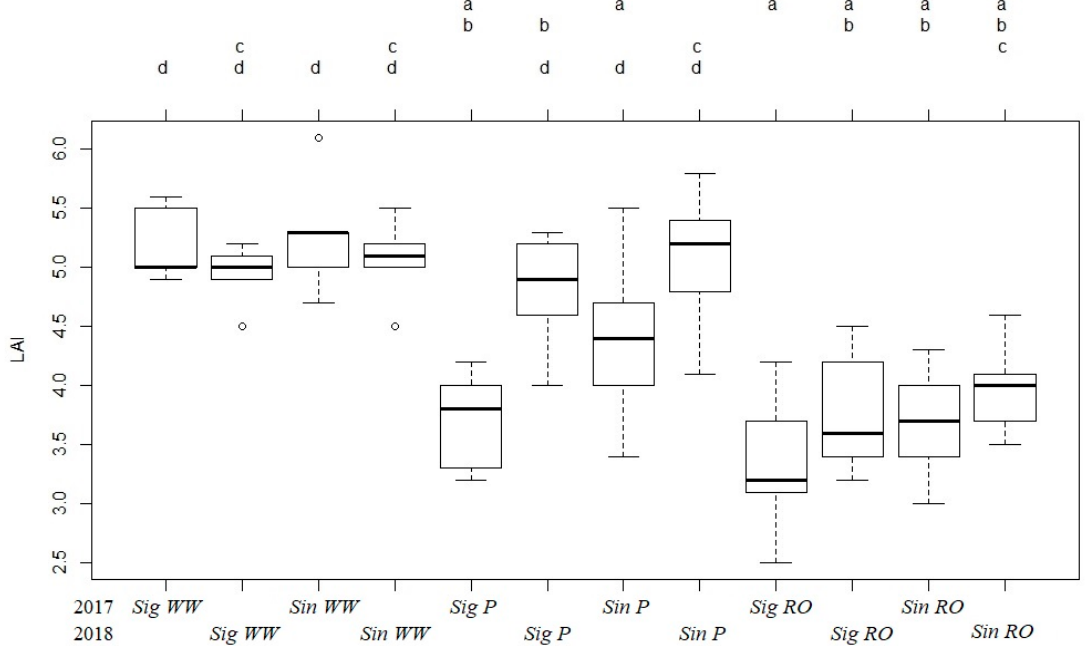
Figure 3. Seasonal mean leaf area index ( LAI ) of soybean varieties Sinara ( Sin ) and Sigalia ( Sig ) in rainfed ( P ), unlimited ( WW ) and water-stressed ( RO ) conditions over two consecutive growing seasons (2017 and 2018) at Keszthely, in Hungary. Lower-case letters at the top of the graph indicate the LAI subsets by Tukey’s test.